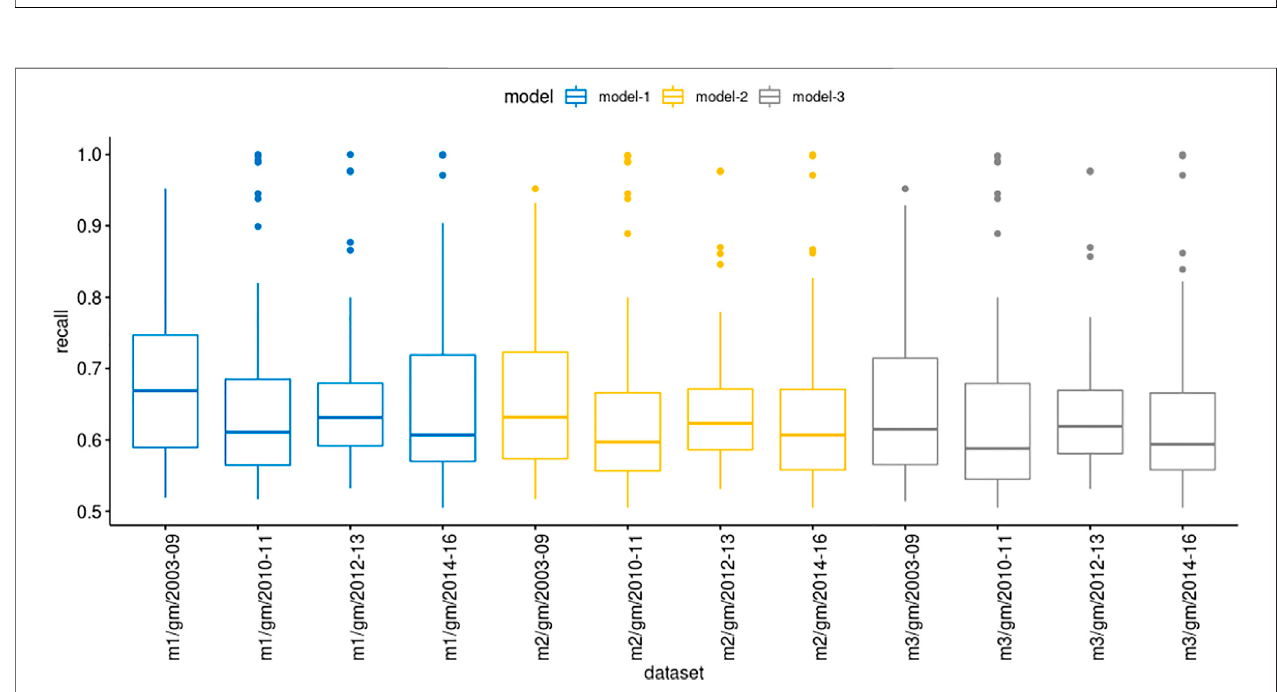
FIGURE 4 | Comparison of recall values showing the mean location and distribution of recall values in each group of genemania datasets.